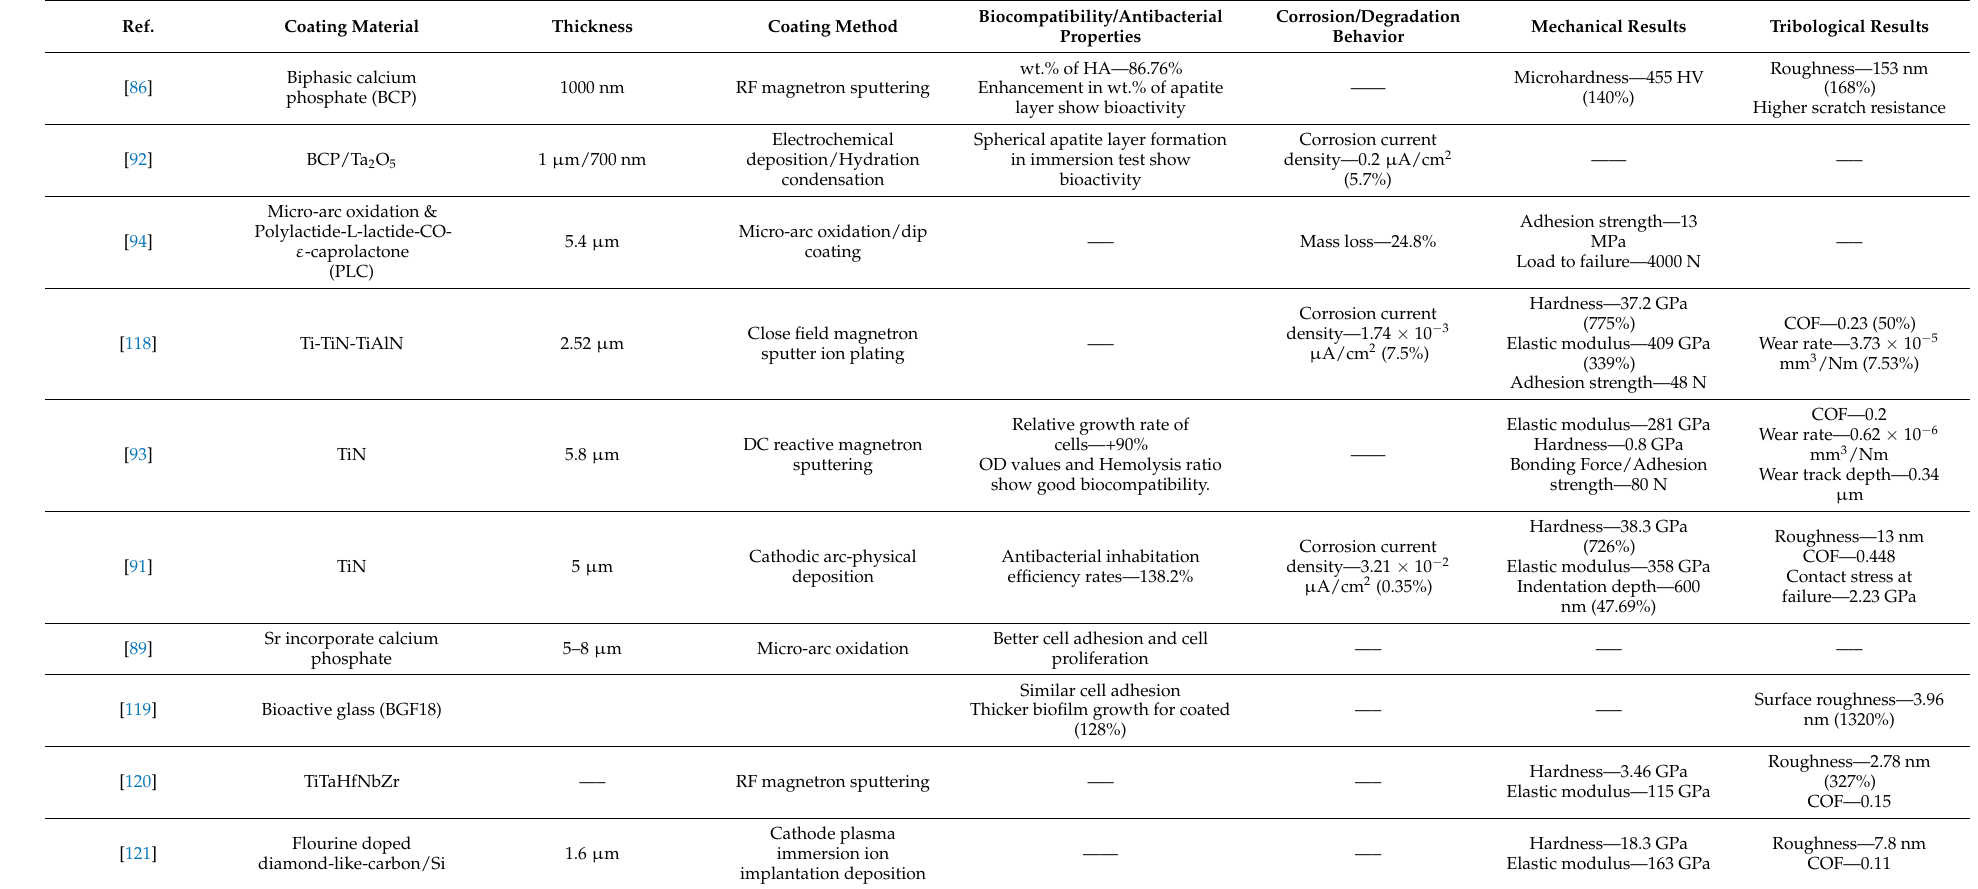
Table 3. Summary of results for coatings on titanium